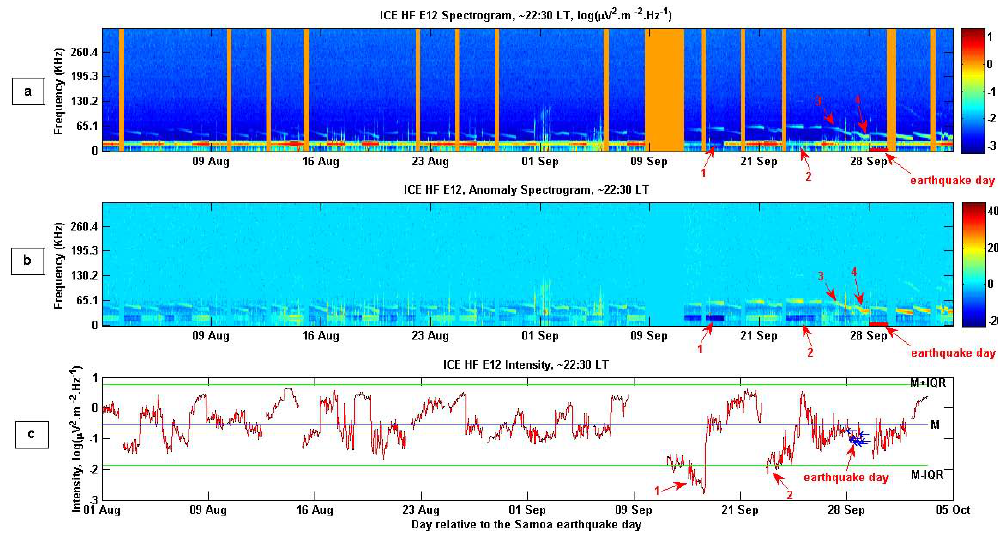
Fig. 4. Same as Fig. 2 but for ICE HF spectrogram of the E12 electric